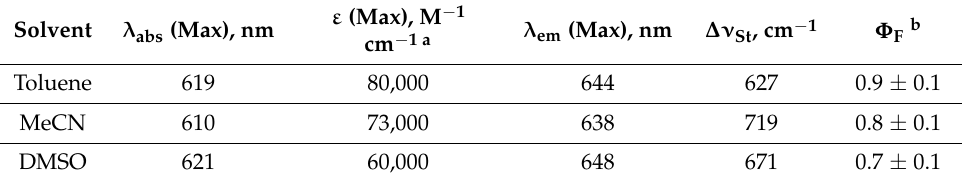
Table 1. Spectroscopic and photophysical characteristics of BODIPY 1 at 22 ◦